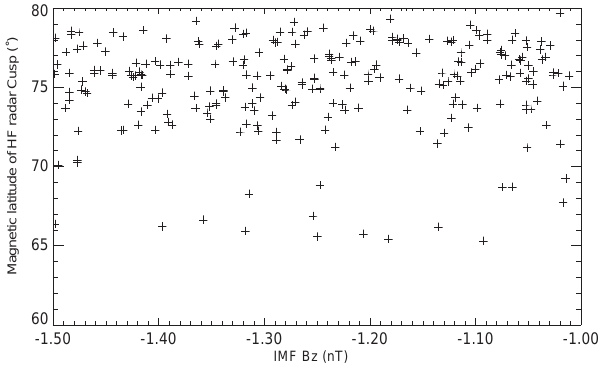
Fig. 3. The average location of the HF radar cusp as a function of the prevailing IMF B Z component (solid line). The dashed lines represent ± 1 standard deviation of the distribution of latitude val- ues. Only averages where more than 25 data points per bin were available are